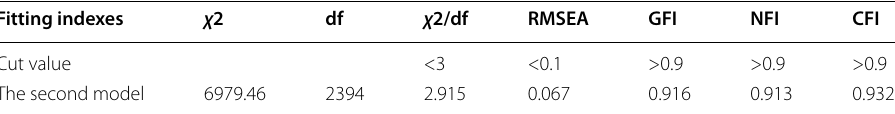
Table 4 Model fit